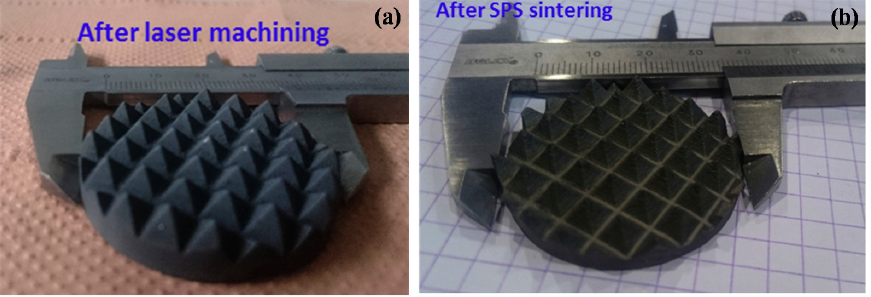
Figure 3. Photograph of the bushhammer part in WC-12%Co ( a ) before and ( b ) after SPS. Reproduced with permission from reference [25].